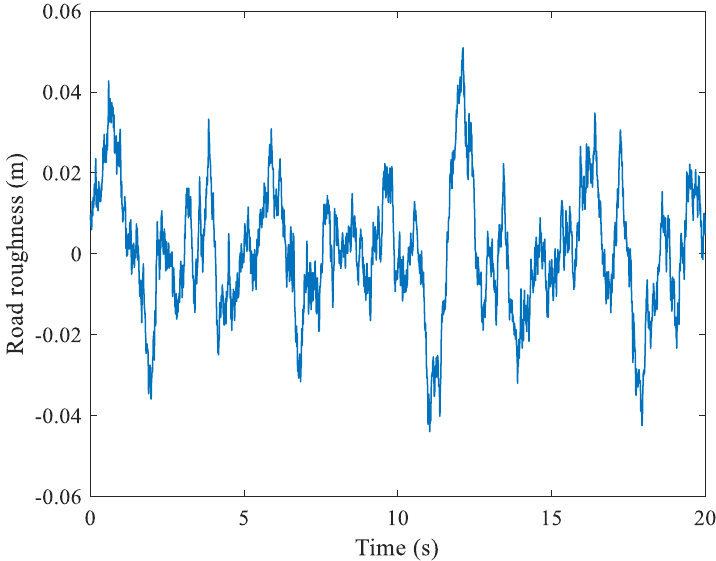
Figure 8. Road roughness profiles of Class C at a speed of 20 m/s. The optimized parameters are substituted into Equation (1) and simulated under the road surface excitation. The simulation pairs under random excitation are shown in Figure 9, and the performance indexes are shown in Table